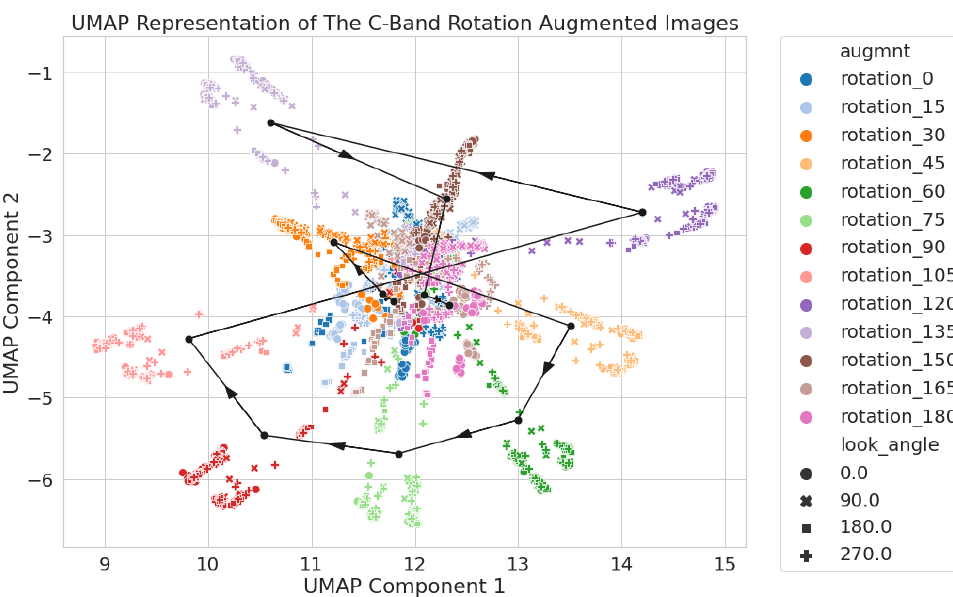
Figure 5. C-band only 2D UMAP latent space using circular crop images. Each augmentation set has its mean location pin-pointed with a black dot and connected via a black line with arrows to show the direction of the increasing rotation